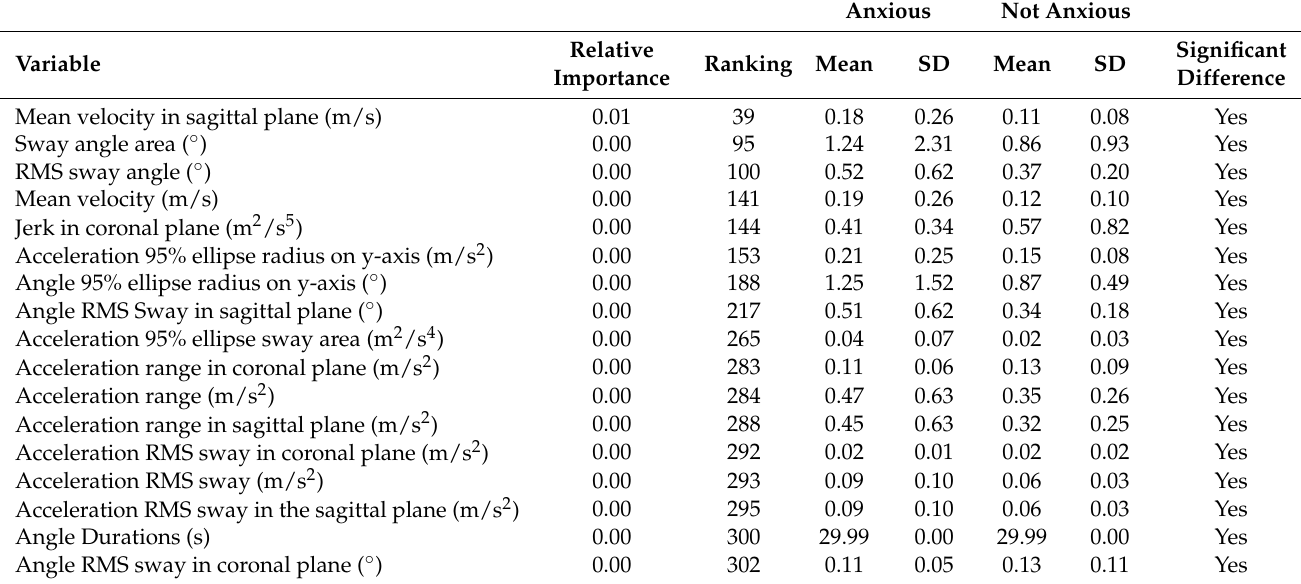
Table 2. Significant Variables Only for Eyes Open, Feet on Ground.